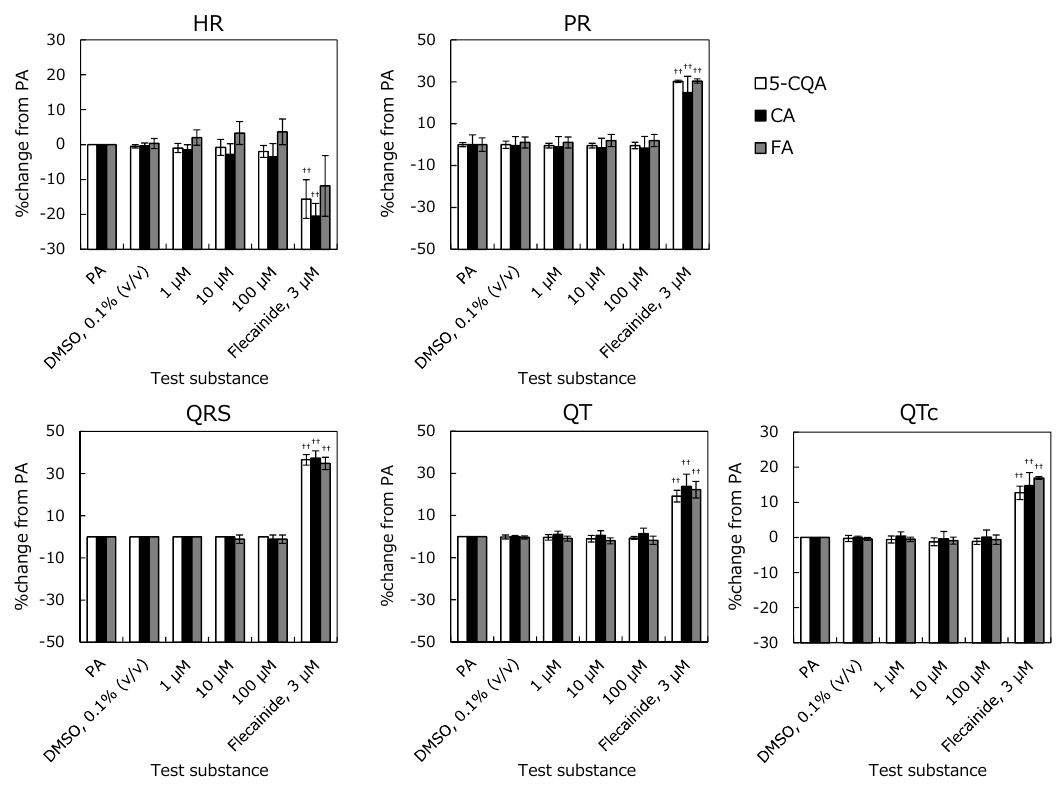
Figure 2. Relationships between electrocardiogram parameters and accumulation of each perfusate. The isolated perfused guinea pig heart was respectively conditioned with 0.1% dimethyl sulfoxide (DMSO), 1 – 10 – 100 µM of 5- O -caffeoylquinic acid (5-CQA), caffeic acid (CA), and ferulic acid (FA), and 3 µM of flecainide. Heart rate (HR), PR, QRS, QT, and QTc values are represented as % change from Pre-application (PA). Each error bar represents mean ± SD. (n = 3). †† : p < 0.01; Significantly different from DMSO (Student’s t-test).